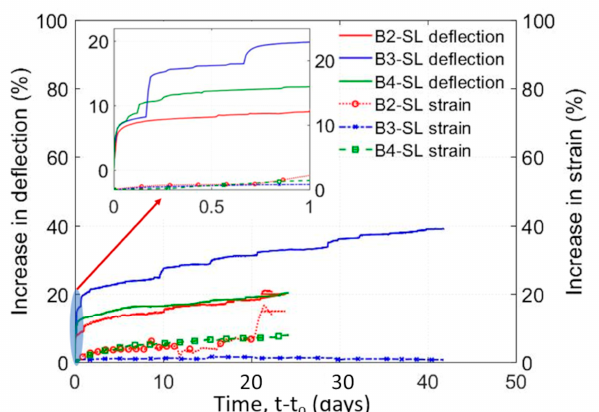
Figure 23. Increase in deflection and strain under sustained load (beams series